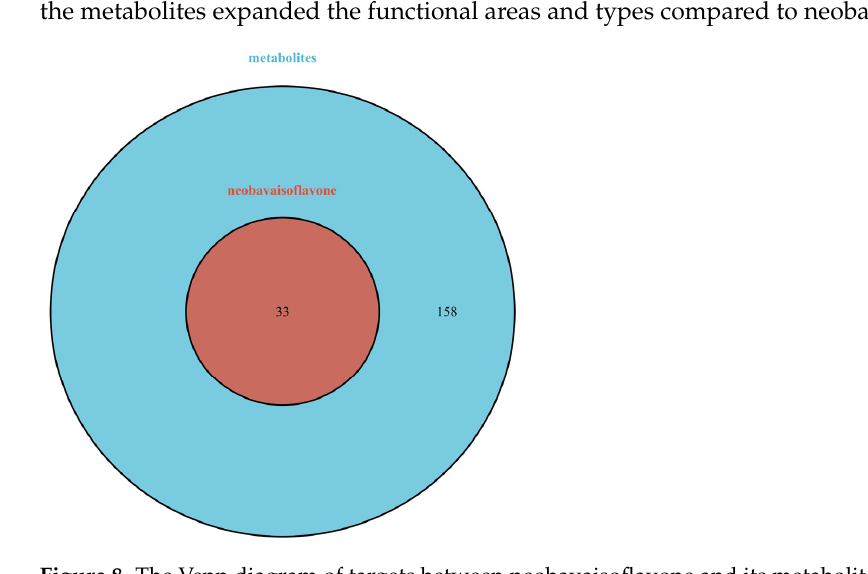
Figure 8. The Venn diagram of targets between neobavaisoflavone and its metabolites. Blue: targets of metabolites; red: targets of neobavaisoflavone.